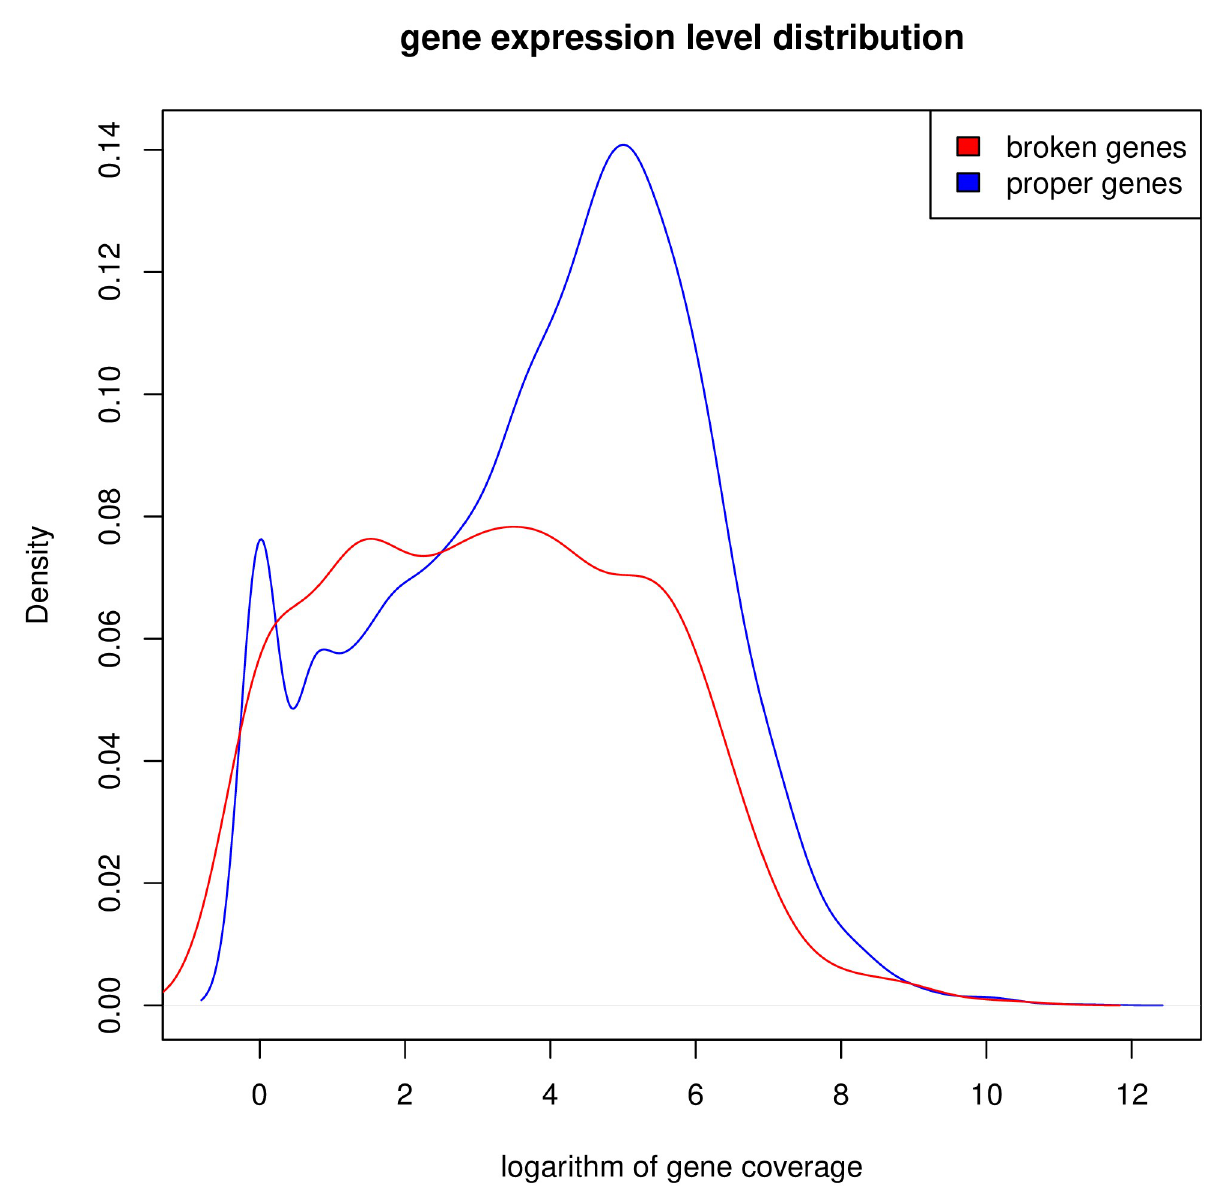
Fig 3. Distribution of levels of peach gene expressions according to Prunus var. Royal Glory. The expression of genes, broken in ‘Sovetskiy’ variety is shown in red colour.